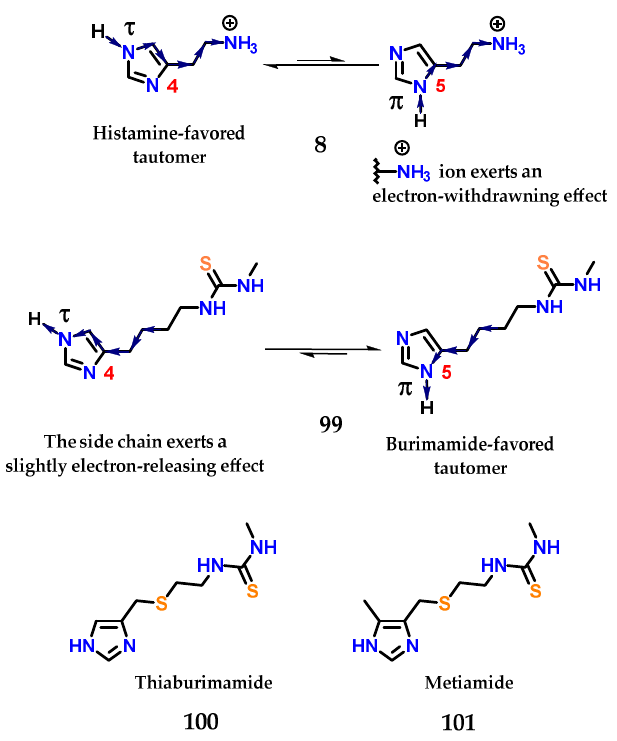
Figure 41. Preferred tautomeric forms of histamine 8 and burimamide 99 . Thiaburimamide 100 and metiamide 101 derivatives as H 2 receptor antagonists.